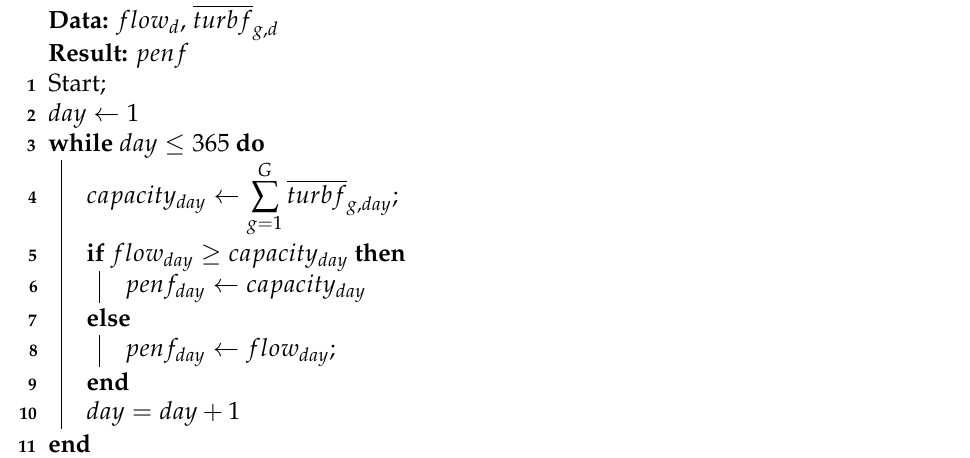
Algorithm 1: Algorithm for the Calculation of Penalty Affluent Flow.